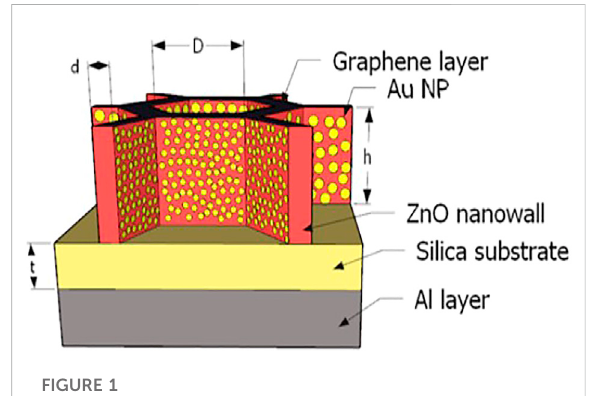
FIGURE 1 Schematic diagram of the proposed nanowall CO 2